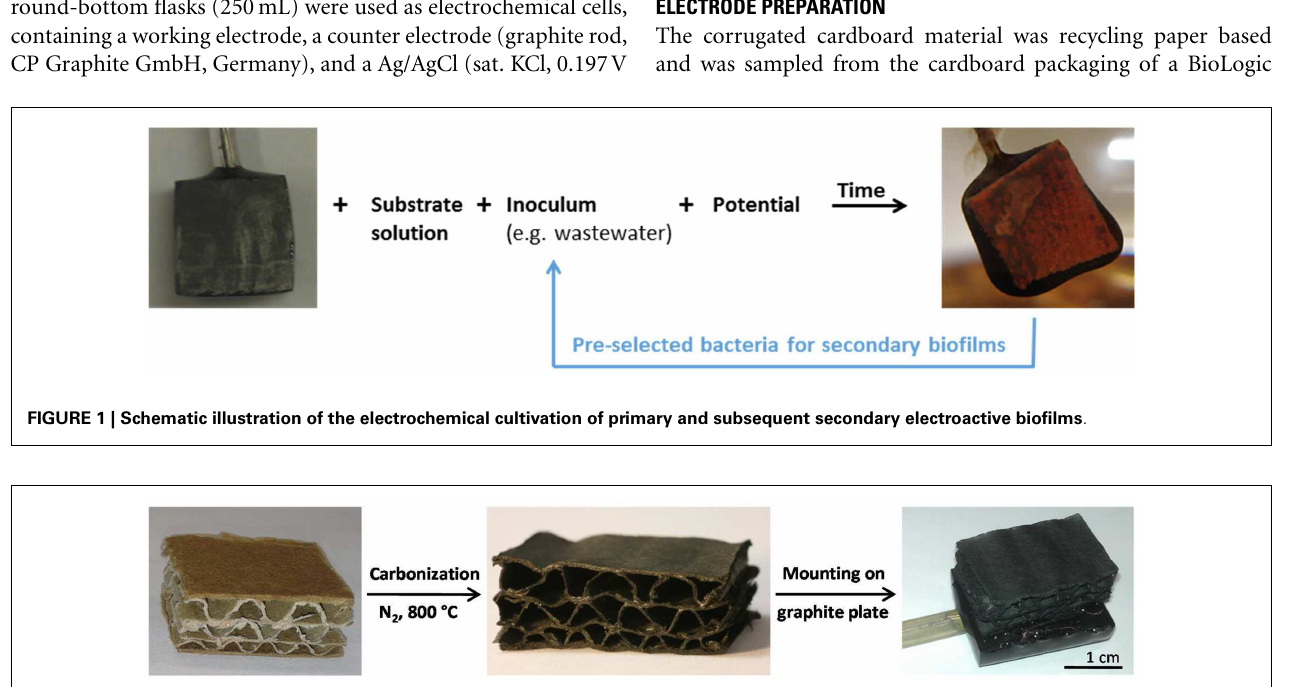
consisted of a graphite current collector (the back and the sides being isolated with epoxy glue), stainless steel wire (covered with a silicone tube), and the layered corrugated carbon material.